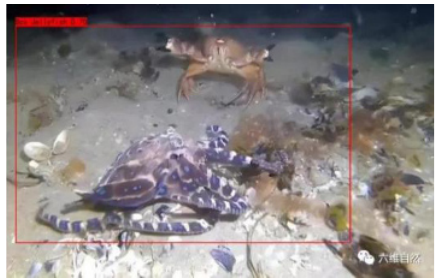
Fig. 12. YOLOX detection results after super- resolution processing with ESRGAN.